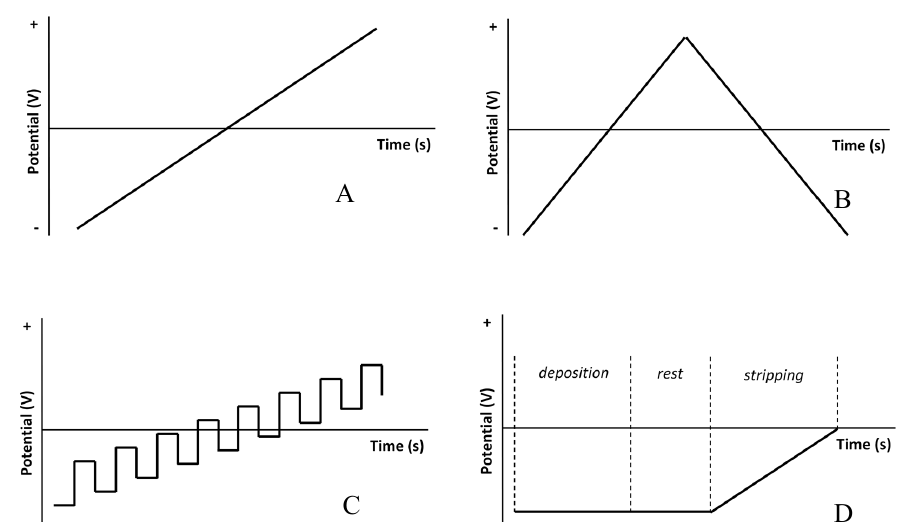
Figure 4. ( A ) Potential vs. time signal for linear sweep; ( B ) Potential vs. time signal for cyclic voltammetry; ( C ) Potential vs. time signal for square wave voltammetry; ( D ) Potential vs. time signal for stripping voltammetry. Anodic stripping is shown in this case.